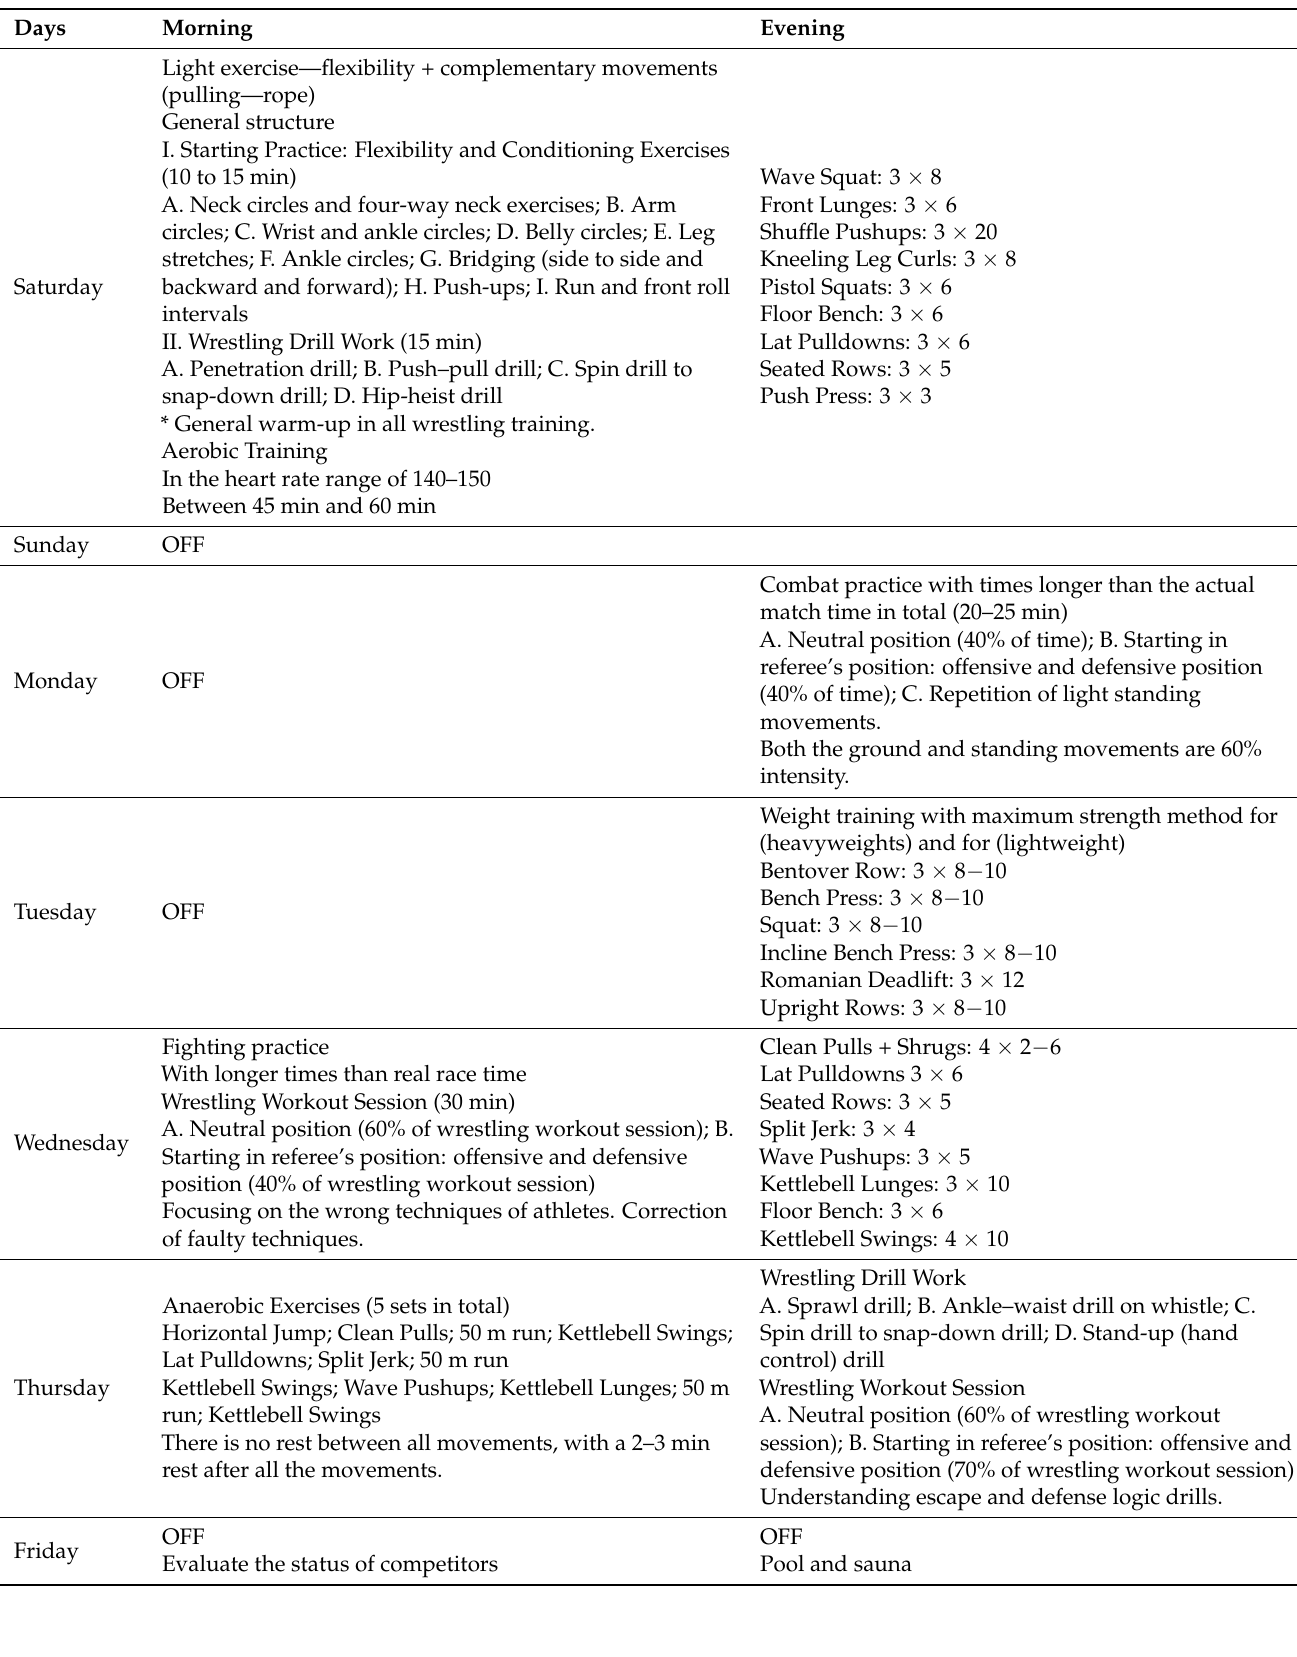
Table 4. Design of a microcycle in the end of the preparation